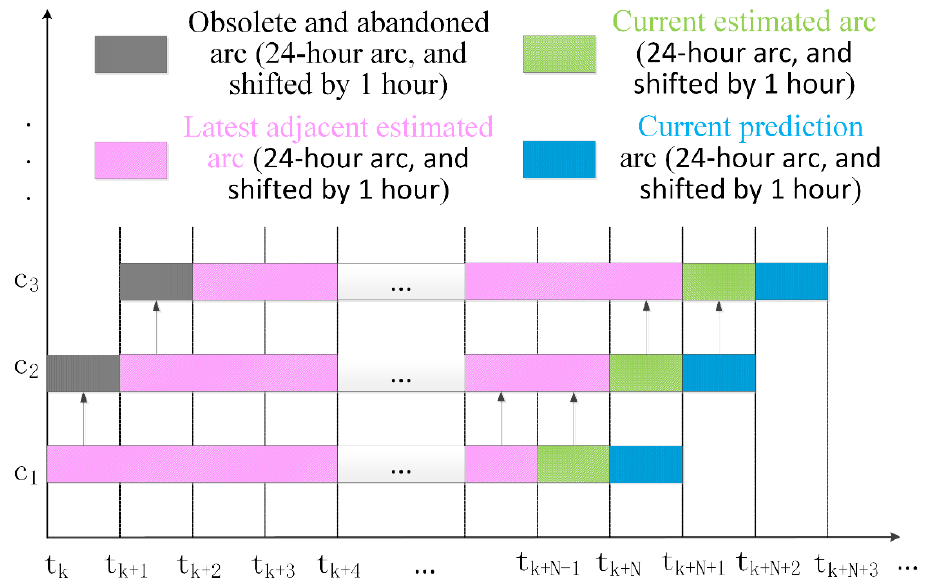
Figure 2. Flowchart of ultrarapid orbit determination and prediction.